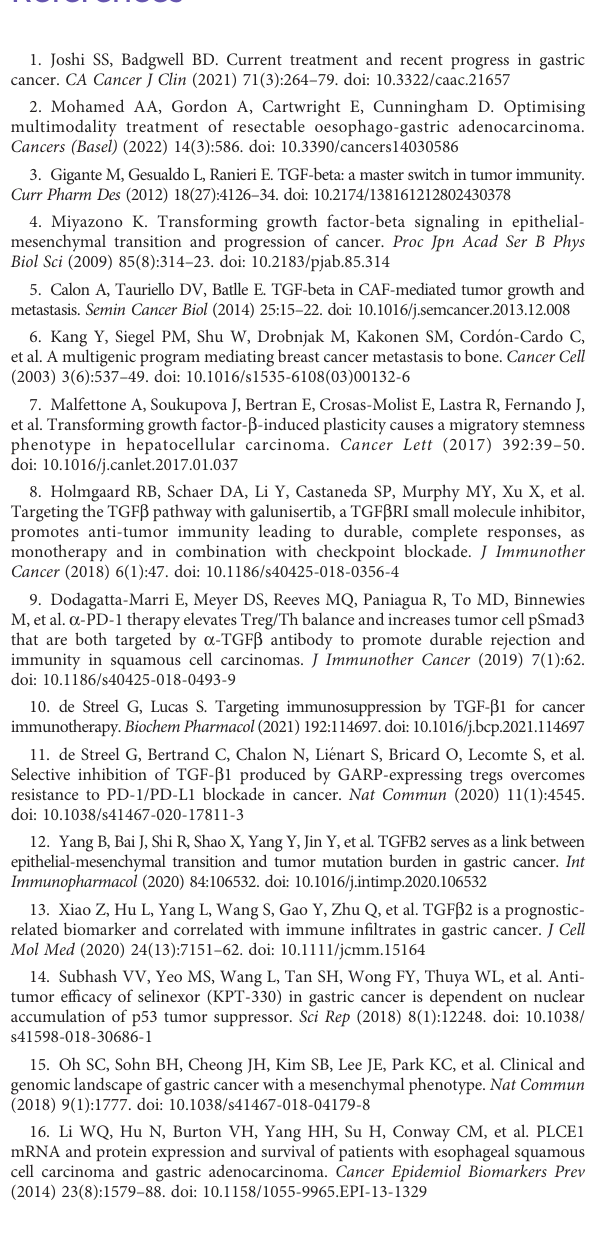
SUPPLEMENTARY FIGURE 2 AnalysisofcopynumbervariationamongdifferentTGF b groups. (A,C,E) Comparison of the frequency of copy number changes in different TGF b groupings. Chromosomal locations of peaks of signi fi cantly recurring focal ampli fi cation (red) and deletions (blue) were presented. (B – D) Comparison of tumor in fi ltration levels betweentumorswithdifferentsomaticcopynumberalterationsofTGF b .* P <0.05; ** P < 0.01; *** P < 0.001. SUPPLEMENTARY FIGURE 3 TGF b withMHCmoleculesandImmunecheckpoints. (A) Correlationof TGF b with MHC molecules and Immune checkpoints. (B – D) The expression levels ofTGF b 1,TGF b 2andTGF b